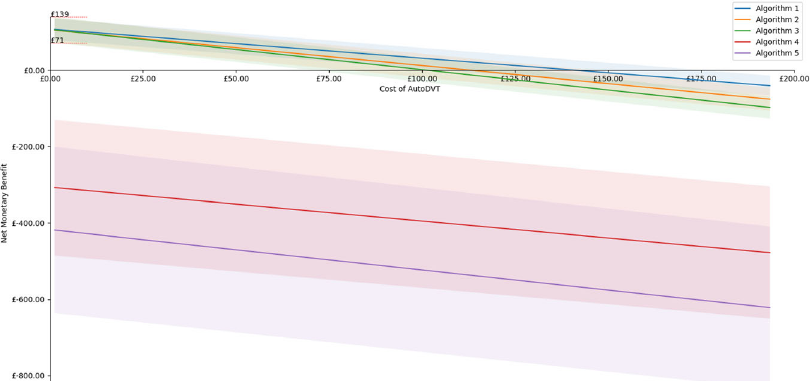
Fig. 6 Costs of the guidance tool vs. net monetary bene fi t (NMB) per examination when implementing ML-guided DVT diagnostics into clinical diagnostic pathways. The NMB has been simulated with a deterministic model for each of the diagnostic algorithm variants in Fig. 11 at the mean (solid line) and the 95 CI interval (shaded area) from Table 5 to show possible optimistic and pessimistic scenarios. The red lines on the y-axis mark the maximal attainable NMB range when examination costs are zero.